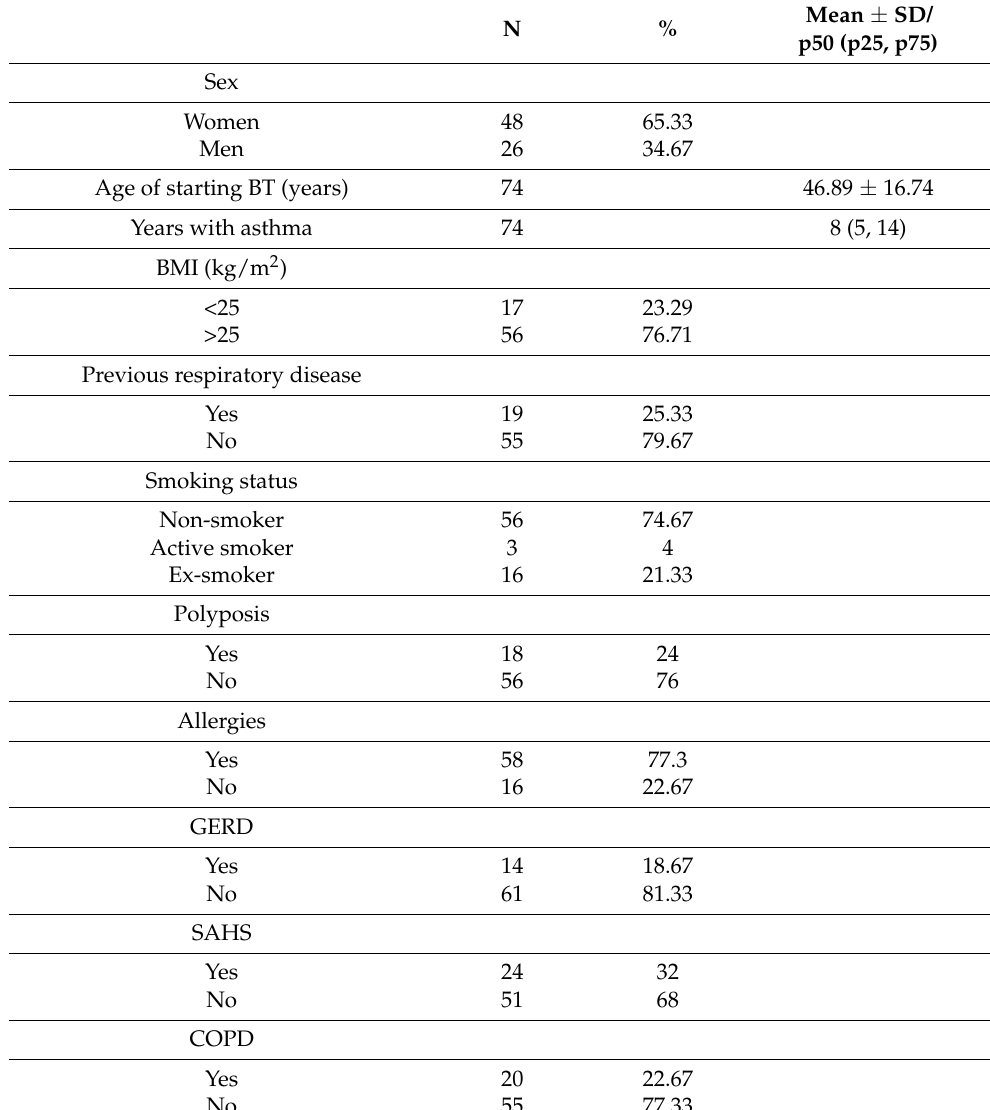
Table 1. Socio-demographic and clinical characteristics of patients treated with